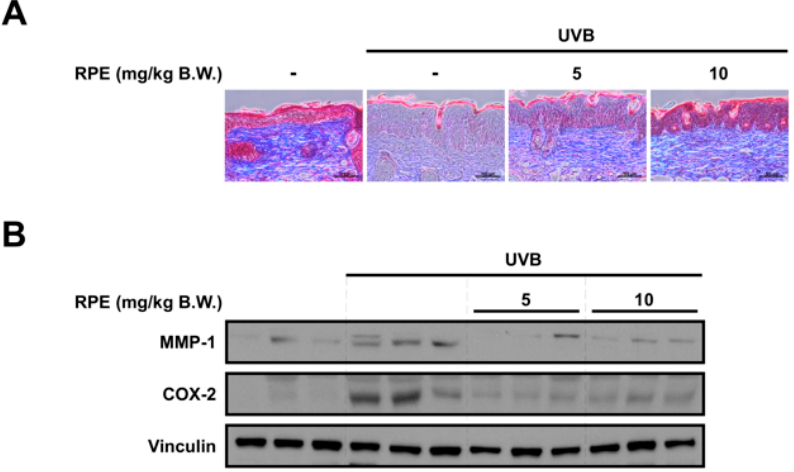
Figure 3. RPE inhibits collagen degradation and reverses biomarkers of skin aging. ( A ) Masson’s trichrome staining for the visualization of collagen and keratin fibers in mouse skin tissue. Collagen fibers appear blue and keratin fibers appear red. The scale bar indicates 100 µ m. ( B ) Protein expression of MMP − 1, COX − 2, and vinculin were determined in mouse tissue lysates using the corresponding antibody. Tissue lysates from three mice per group were used. Vinculin was used as a loading control.